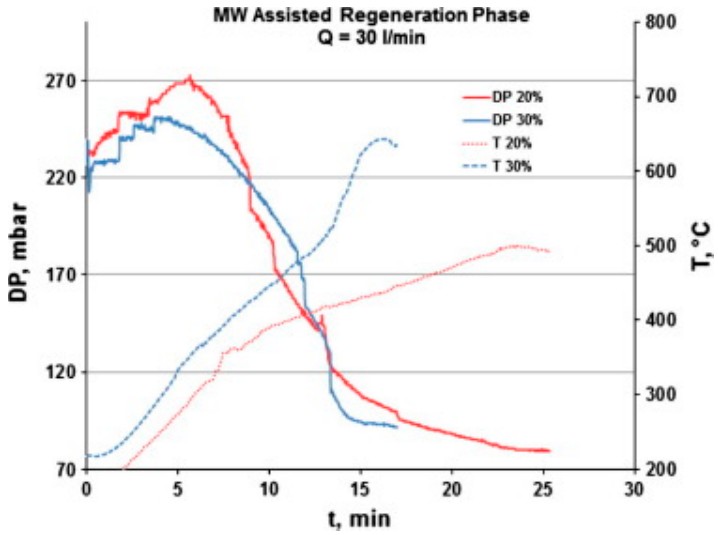
Figure 10. The behavior of the pressure drop through the filter (DP) and temperature profiles during the regeneration phase performed by the microwave generator set at 50% of nominal power and with an exhaust gas flow rate of 30 L/min − 1 [123].